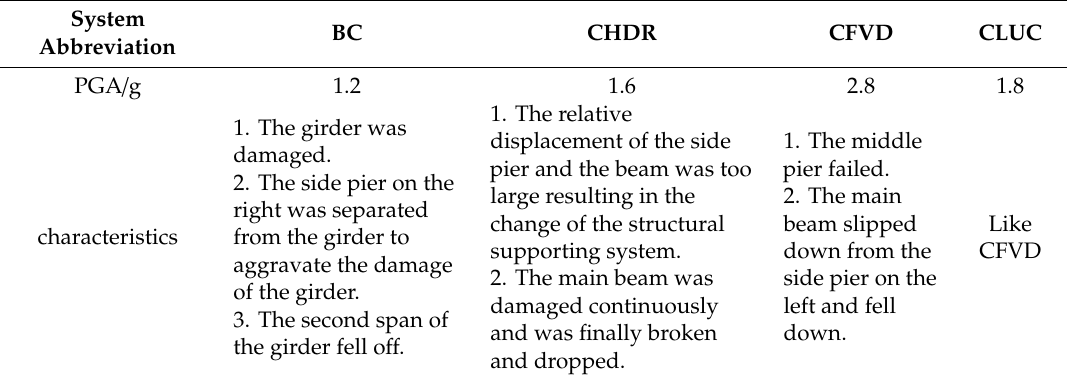
Table 7. Collapse characteristics of the Chi-chi seismic wave case.